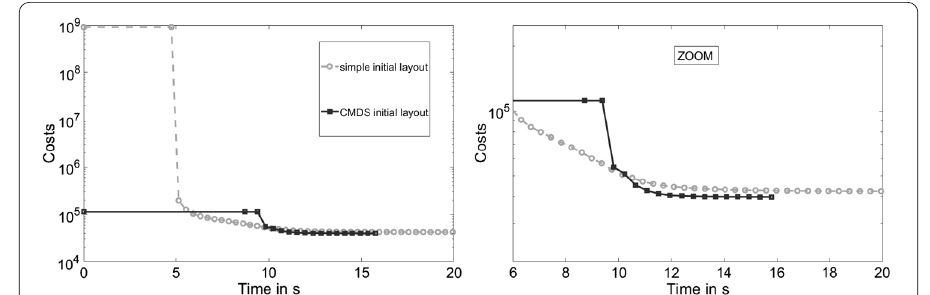
Figure 11 Time-cost plot for various initial layouts for the 1138_bus dataset